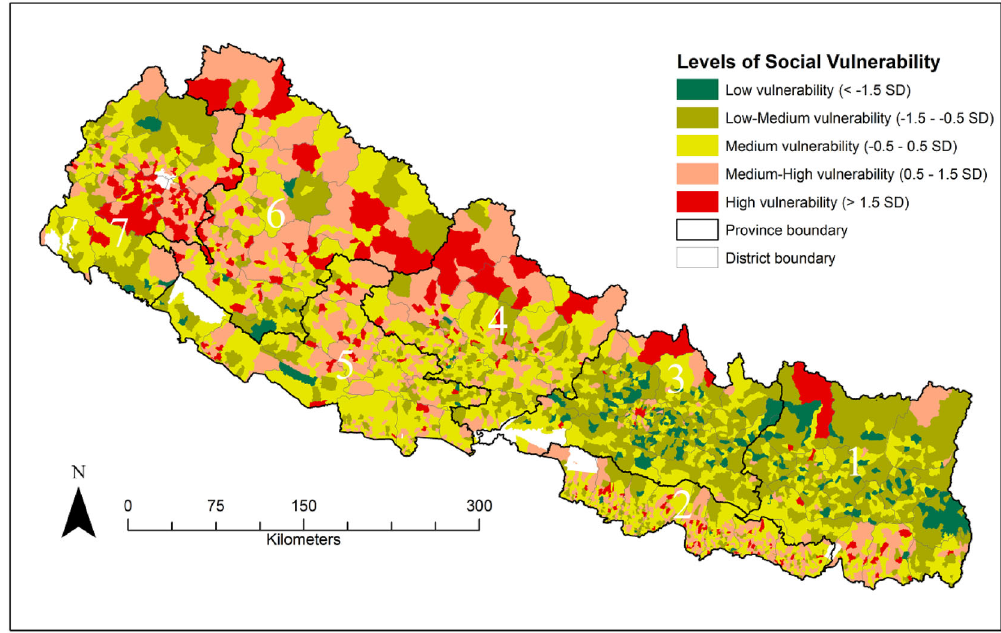
Fig. 2 Spatial distribution of the composite score of social vulnerability using a modified Social Vulnerability Index in the seven provinces of Nepal. The numbers 1–7, as indicated on the map, are the provinces created in 2015 that have yet to be named by the